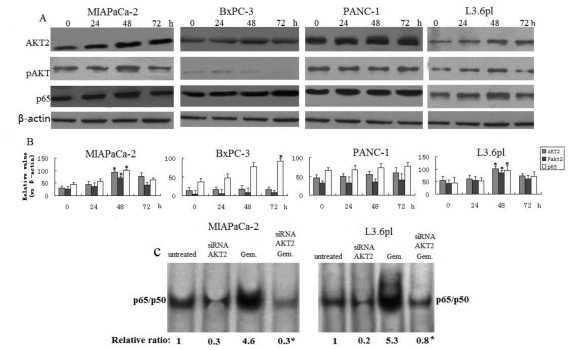
Western blotting and EMSA for AKT2 (pSer473), pAKT and NF-κBp65 following treatment with gemcitabine and/or AKT2 siRNA. (A) Western blotting for AKT2 (pSer473), pAKT and NF-κBp65 in four pancreatic cancer cell lines following treatment with gemcitabine (1 μM) for 72 h in L3.6pl, MiaPaCa-2, BxPC-3 and PANC-1 cells; (B) Relative Akt2 (pSer473), pAKT and NF-κBp65 levels are shown (vs. control,* P < 0.05); (C) Nuclear extracts prepared from L3.6pl and MIAPaCa-2 cells after 48 h incubation with 1 μM gemcitabine combined with 100 MOI AKT2 siRNA were assayed by EMSA.